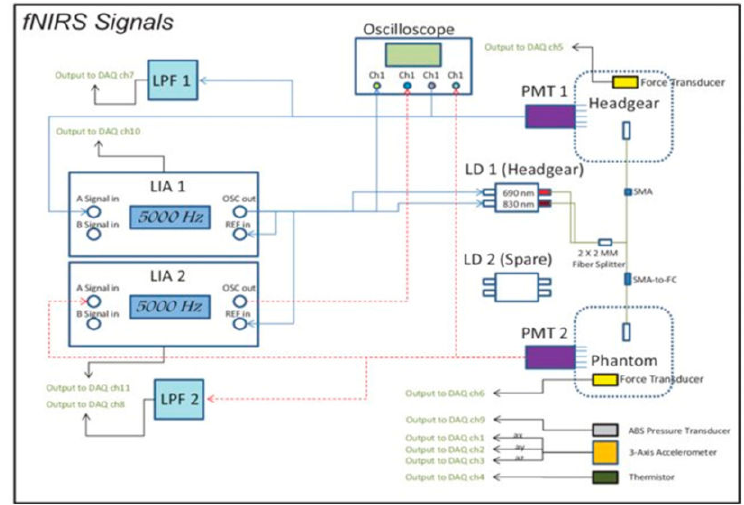
Figure 15. Schematic of fNIRS experimentation under different levels of gravity for the accuracy of signal generation. (Reprinted from